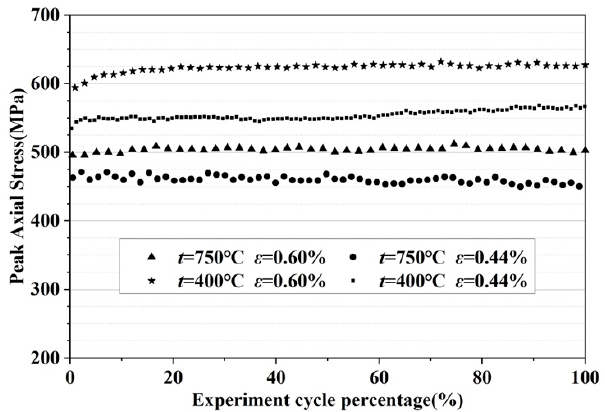
Figure 4. Cyclic peak stress of the TiAl alloy at different temperatures.